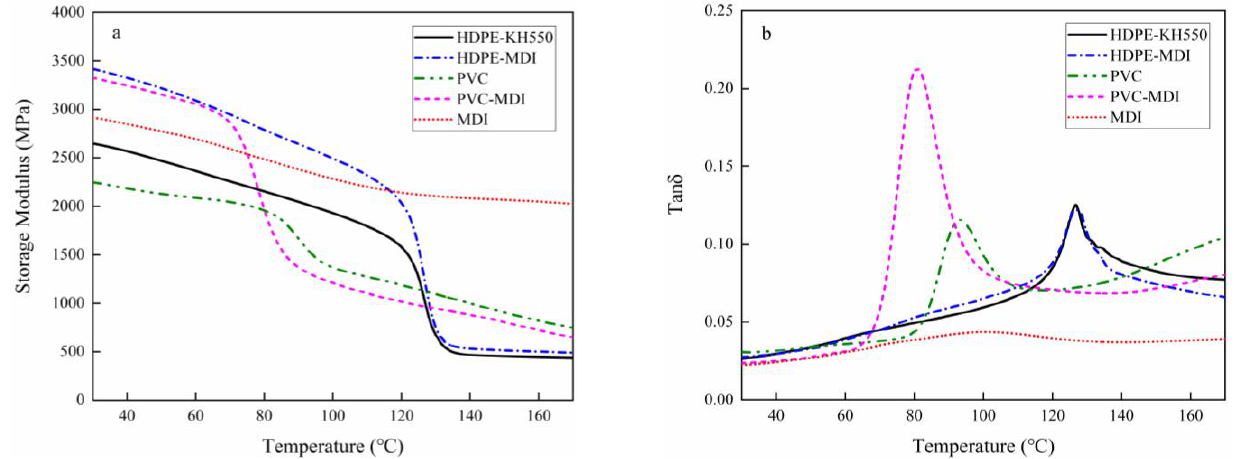
Figure 3. ( a ) Storage modulus and ( b ) loss tangent of VPC with: HDPE as the thermoplastic and KH550 as the coupling agent (HDPE-KH550); HDPE as the thermoplastic and MDI as the coupling agent (HDPE-MDI); PVC as the thermoplastic and no coupling agent (PVC); PVC as the thermoplastic and MDI as the coupling agent (PVC-MDI); and plywood with MDI as the adhesive (MDI).